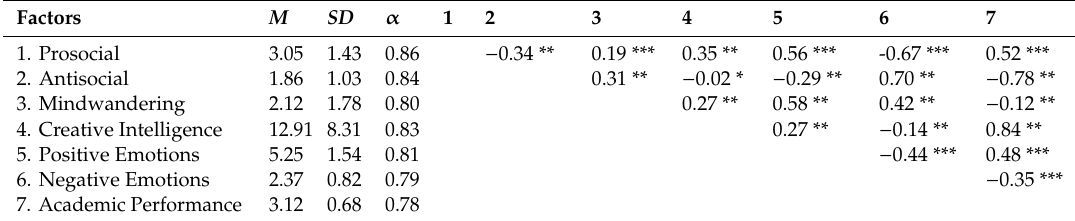
Table 3. Descriptive statistics and reliability